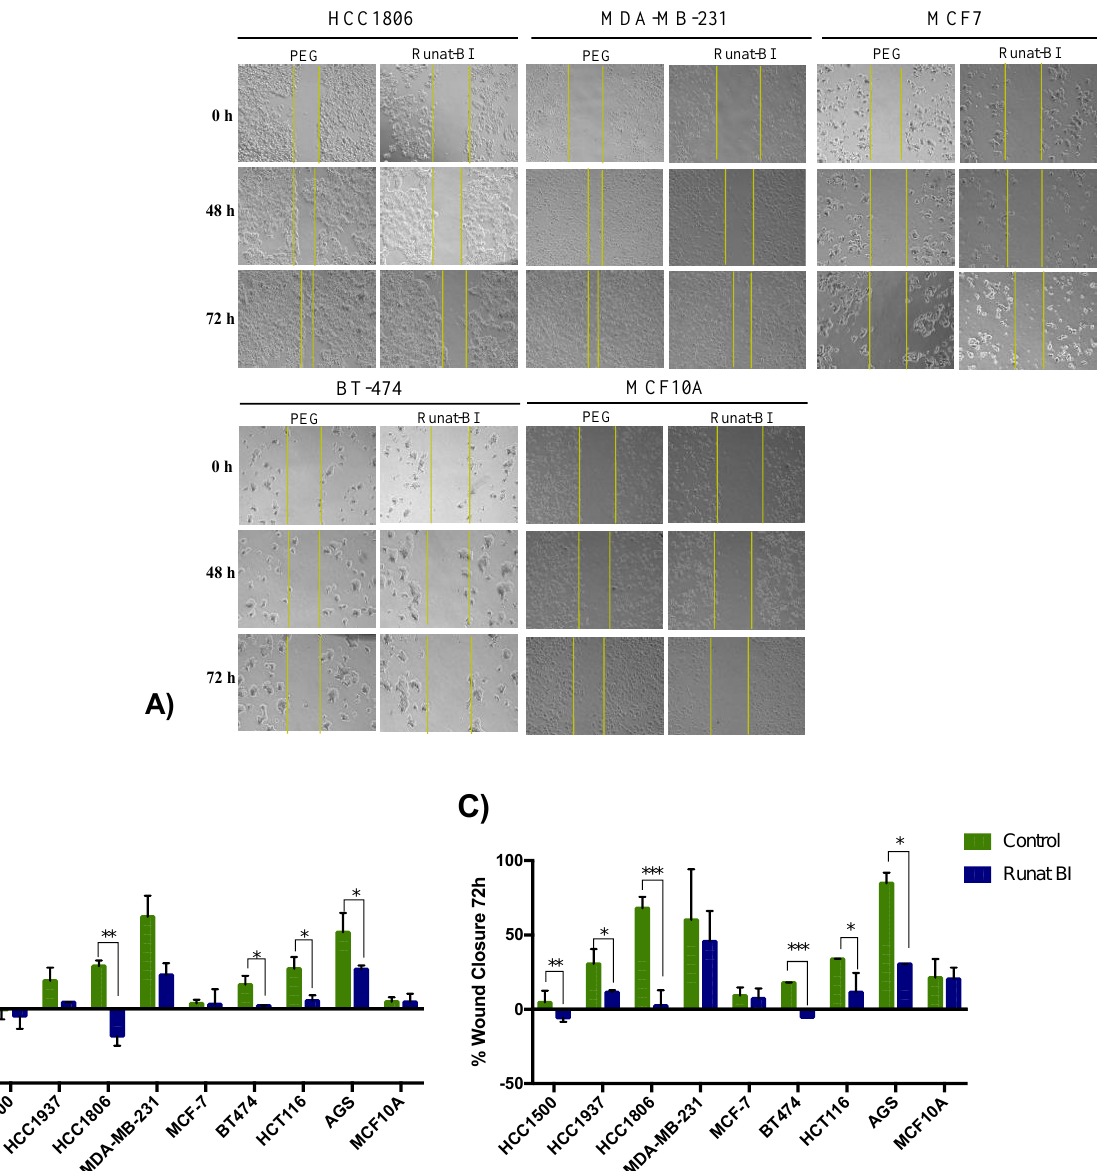
Figure 3. Effect of Runat-BI treatment on cell migration. Cell migration of HCC1806, MDA-MB-231, AGS, HCT116 and MCF10A lines was measured by scratch/wound-healing assay after treatment with Runat-BI (21 µ M) or PEG/control for 48 and 72 h. ( A ): Images of cell migration at 0, 48 and 72 h after Runat-BI (21 µ M) treatment or PEG (control). Three separate experiments were performed, and the most representative results are presented (5 × amplification). Columns express the mean ± SD of the percentage of closure in three independent experiments for 48 h ( B ) and 72 h ( C ). Green bars represent control/PEG and dark blue bars represent Runat-BI-treated cells. * p ≤ 0.1, ** p ≤ 0.05, *** p ≤ 0.01 were considered statistically